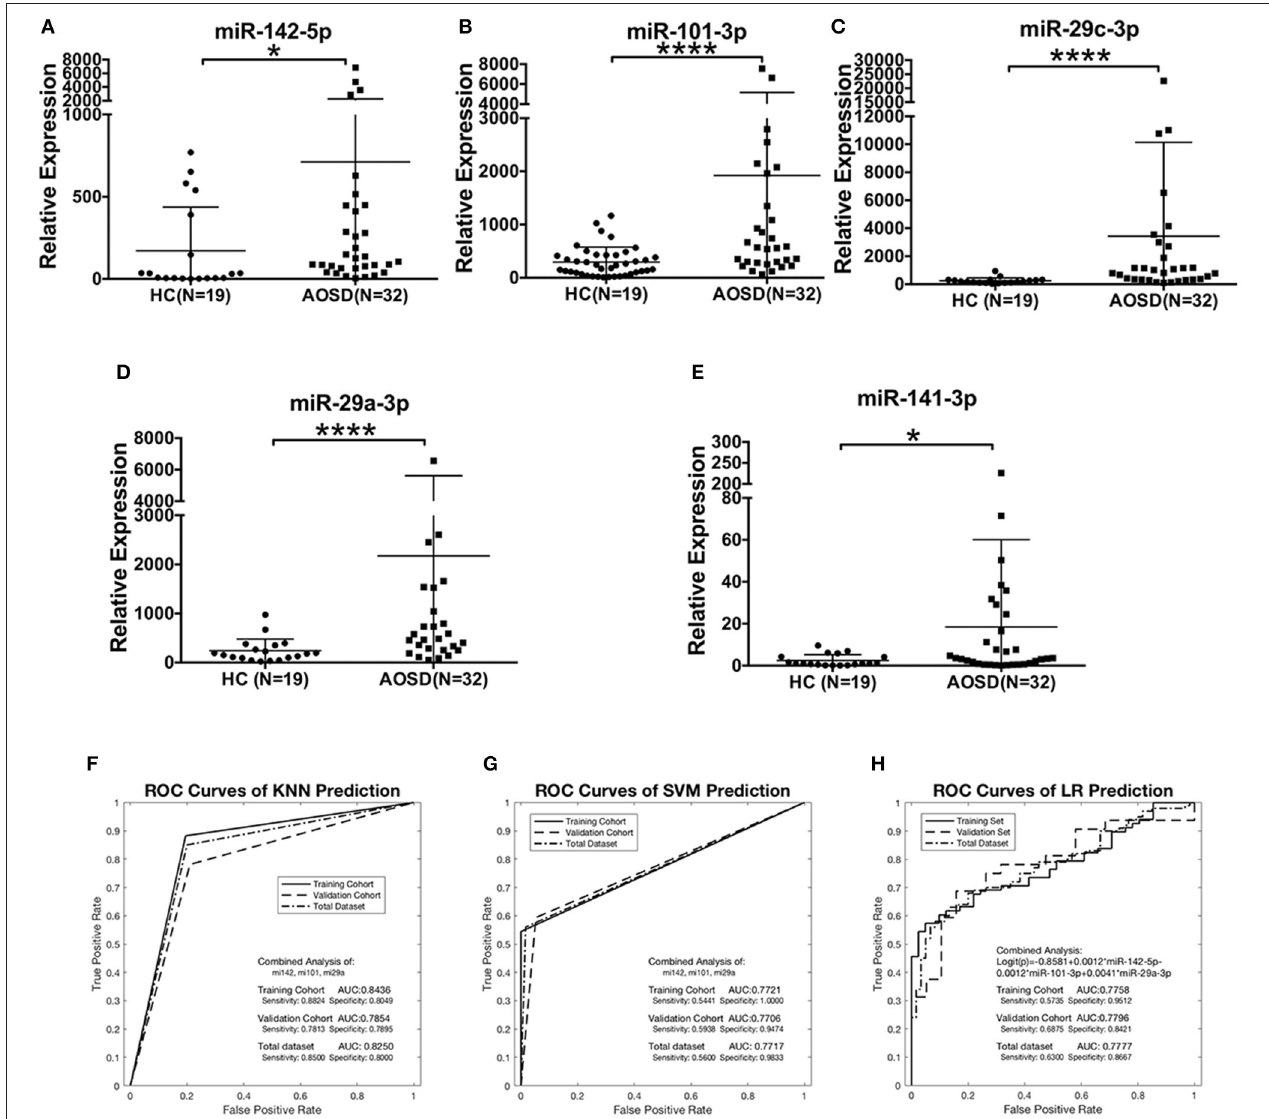
FIGURE 3 | The plasma miRNAs panel for AOSD diagnosis in a validation set. Expression levels of (A) miR-142-5p, (B) miR-101-3p, (C) miR-29c-3p, (D) miR-29a-3p, (E) miR-141-3p were analyzed by qRT-PCR in plasma from AOSD ( N = 32) and HCs ( N = 19). The results of histograms represent the means ± SD, * P < 0.05, **** P < 0.0001. (F-H) ROC analysis for individual miRNAs and combined miRNA panel was analyzed by KNN (F) , SVM (G) , and LR (H) analysis. Logistic regression demonstrated that a linear combination of values for miR-142-5p, miR-101-3p, and miR-29a-3p produced the best model for AOSD